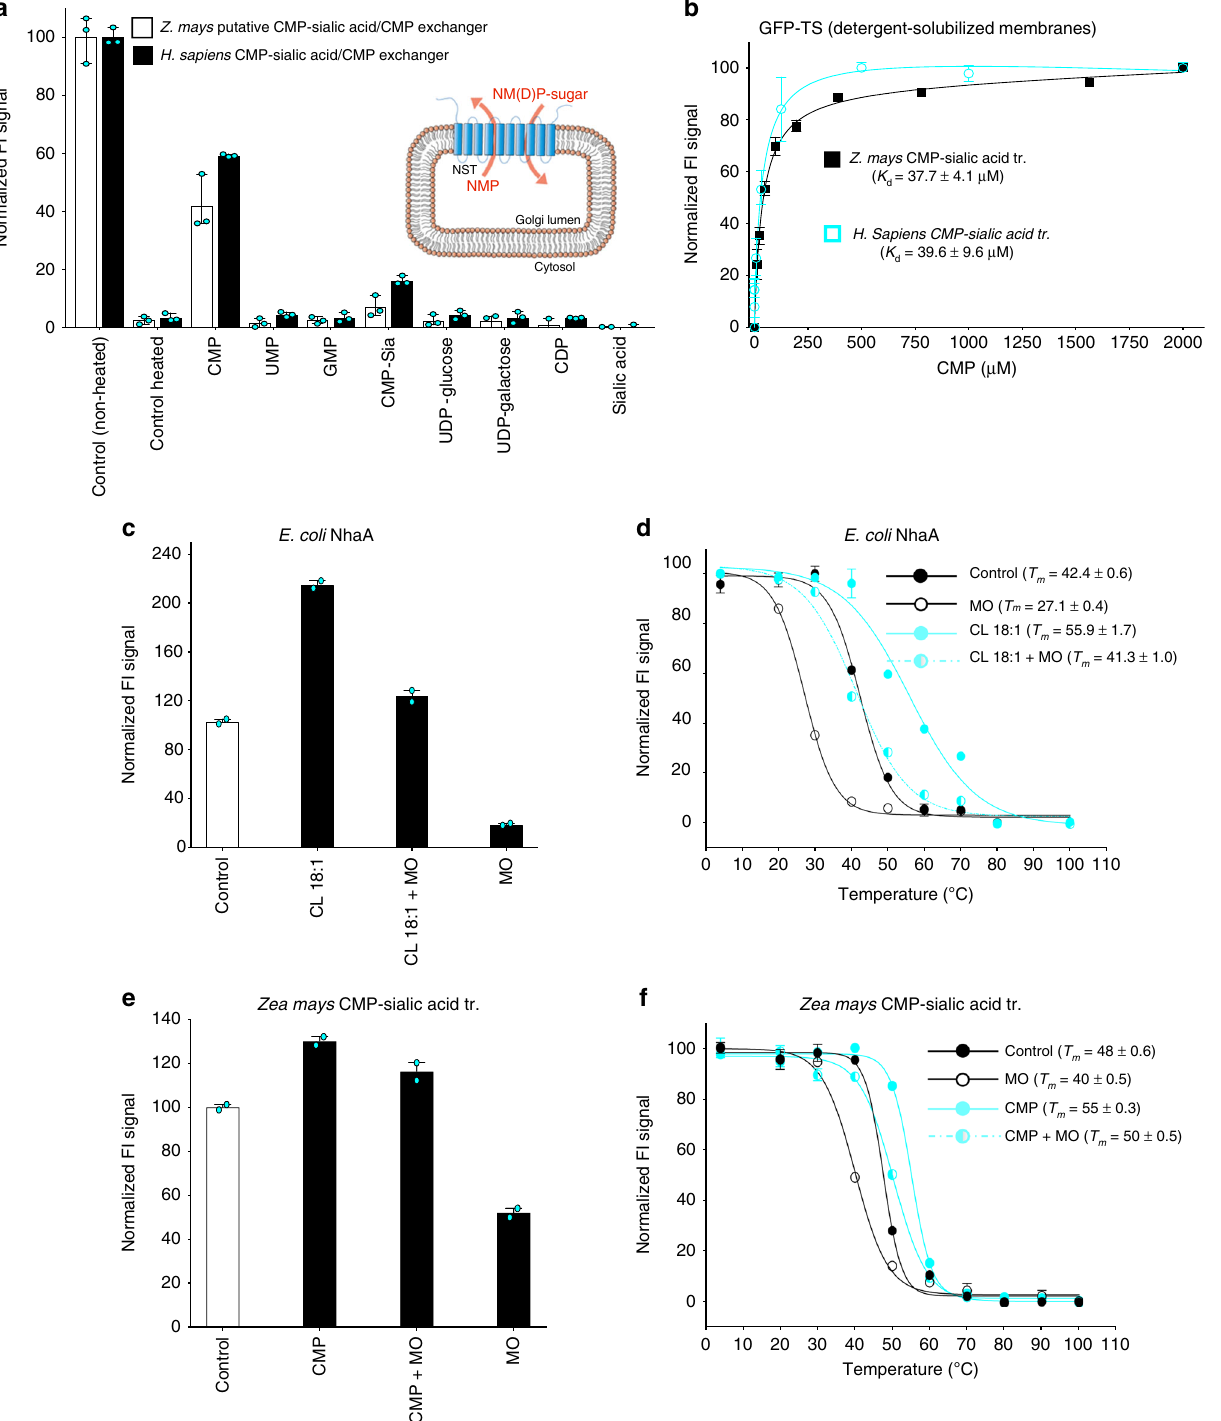
cardiolipin content of E. coli membranes also increases 39 , the cardiolipin-mediated tuning of NhaA dimerization shown by FSEC-TS implies a potential regulatory mechanism with